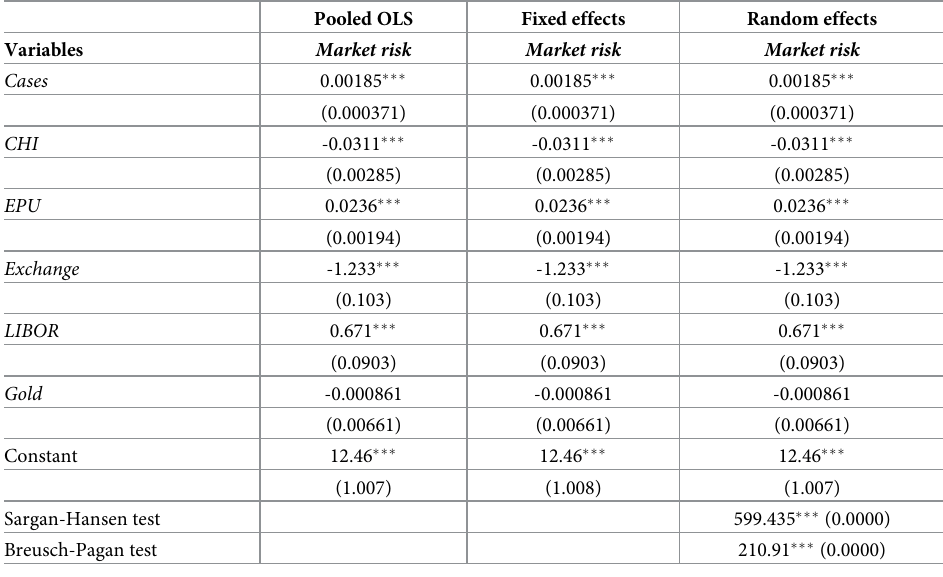
Table 8. Sargan-Hansen test and Breusch and Pagan Lagrangian multiplier